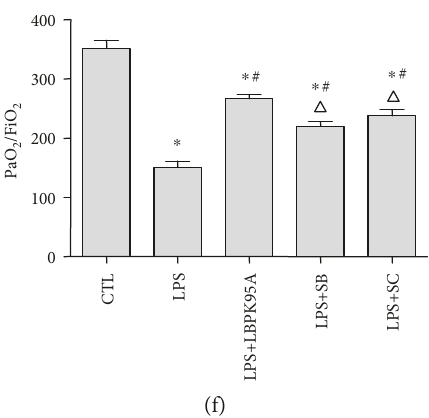
Figure 6: SB203580 and SC-514 ameliorated LPS-induced lung injury and in fl ammation. Hematoxylin and eosin staining was used to determine the LPS-induced lung injury and in fl ammatory response in the lung tissue of the ARDS rat model. (a) The control group rats (A) had a distinct framework with complete alveolar walls and interstitium without ex fi ltration. The LPS group rats (B) showed edema, neutrophil in fi ltration, hemorrhage, moderate bronchiole epithelial desquamation, and minimal hyaline membrane formation. Histotological analysis also show that rats receiving LBPK95A, SB203508, or SC514 injection had substantially less in fl ammatory cell in fi ltration, edema, hemorrhage, and thickness of alveolar walls in comparison to rats treated with LPS ((C), (D), and (E), resp.). The photomicrographs are at 400x magni fi cation. ((b) and (c)) The total number of cells, neutrophil number, and neutrophil ratio in BALF were higher in the LPS group than that in the control group and lower in the LPS+LBPK95A, LPS+SB, and LPS+SC groups than that in the LPS group ( p < 0 05 , n = 10 , in all cases). The MPO of lung tissues and BALF was determined by ELISA. The results show that the level of MPO concentration in the LPS group was signi fi cantly higher than that in the control group ( p < 0 05 ). (d) However, the MPO concentration level in the LPS+LBPK95A, LPS+SB, and LPS+SC groups was signi fi cantly lower than that in the LPS group ( p < 0 05 in all cases). (e) The LPS group had a signi fi cantly higher W/D ratio than the control group, and the W/D ratio in the LPS+LBPK95A, LPS+SB, and LPS+SC groups were signi fi cantly lower than that in the LPS group ( p < 0 05 in all cases). The LPS group had a lower PaO